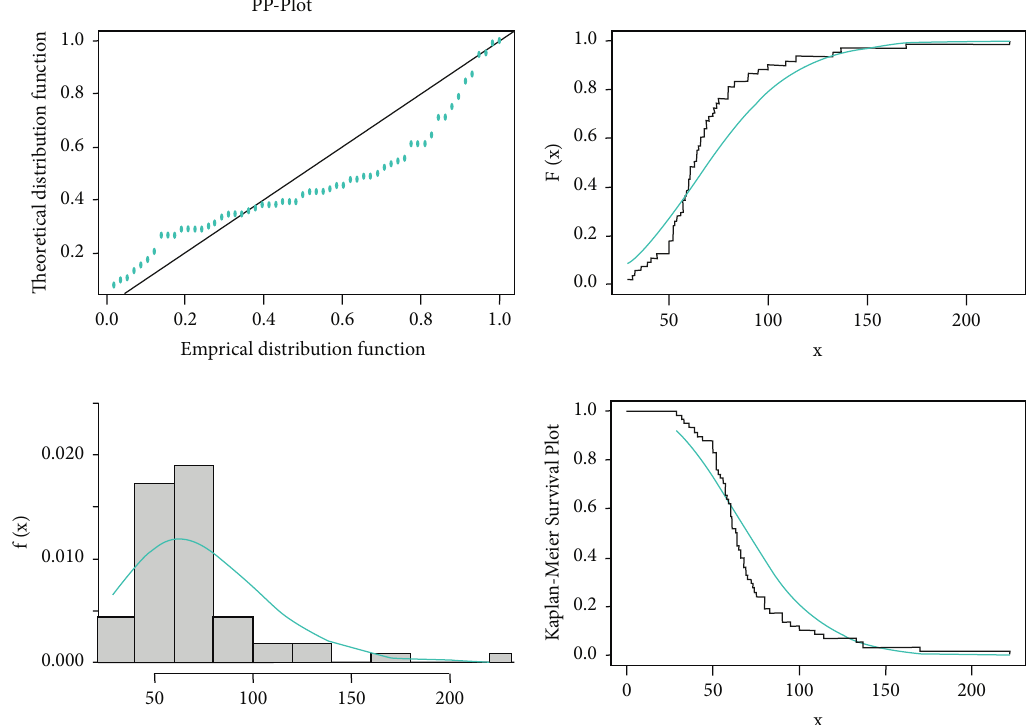
Figure 10: Visual display of the estimated PP, cdf, pdf, and Kaplan–Meier plots of the AT-W distribution for the insurance data